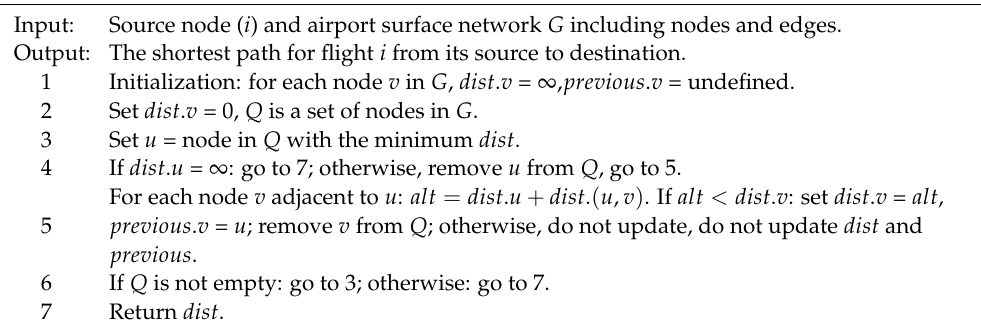
Algorithm 2. The Dijkstra algorithm for scheduling the shortest path for departure flight